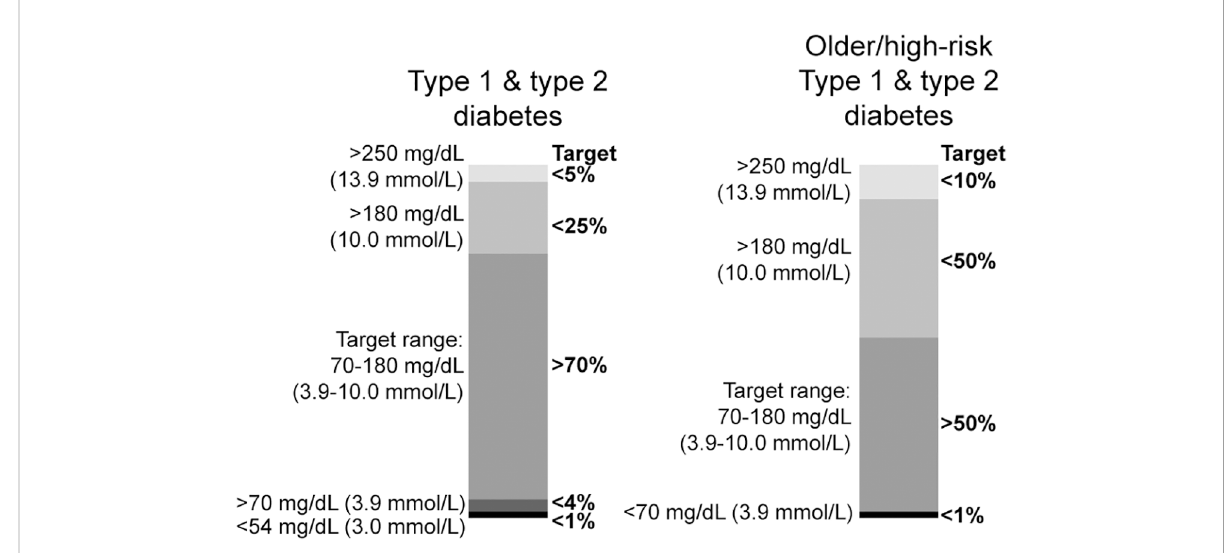
FIGURE 6 Consensus recommendations for CGM-based targets in different diabetes populations (see text). Modi fi ed with permission from Ref